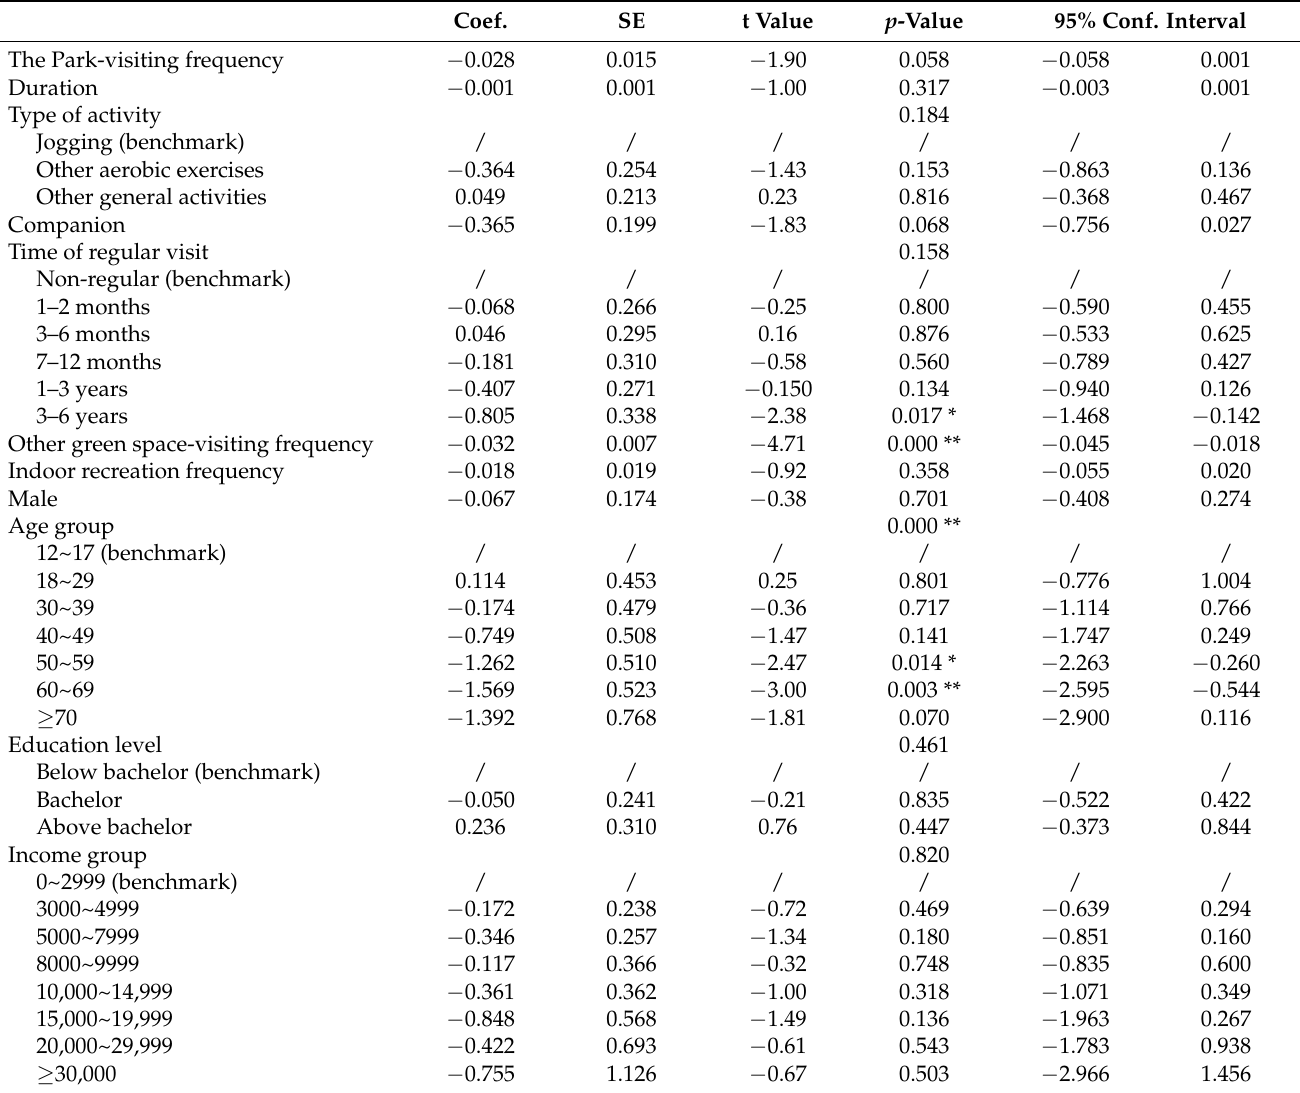
Table 7. Results from general linear regression on related recreational features of visitors’